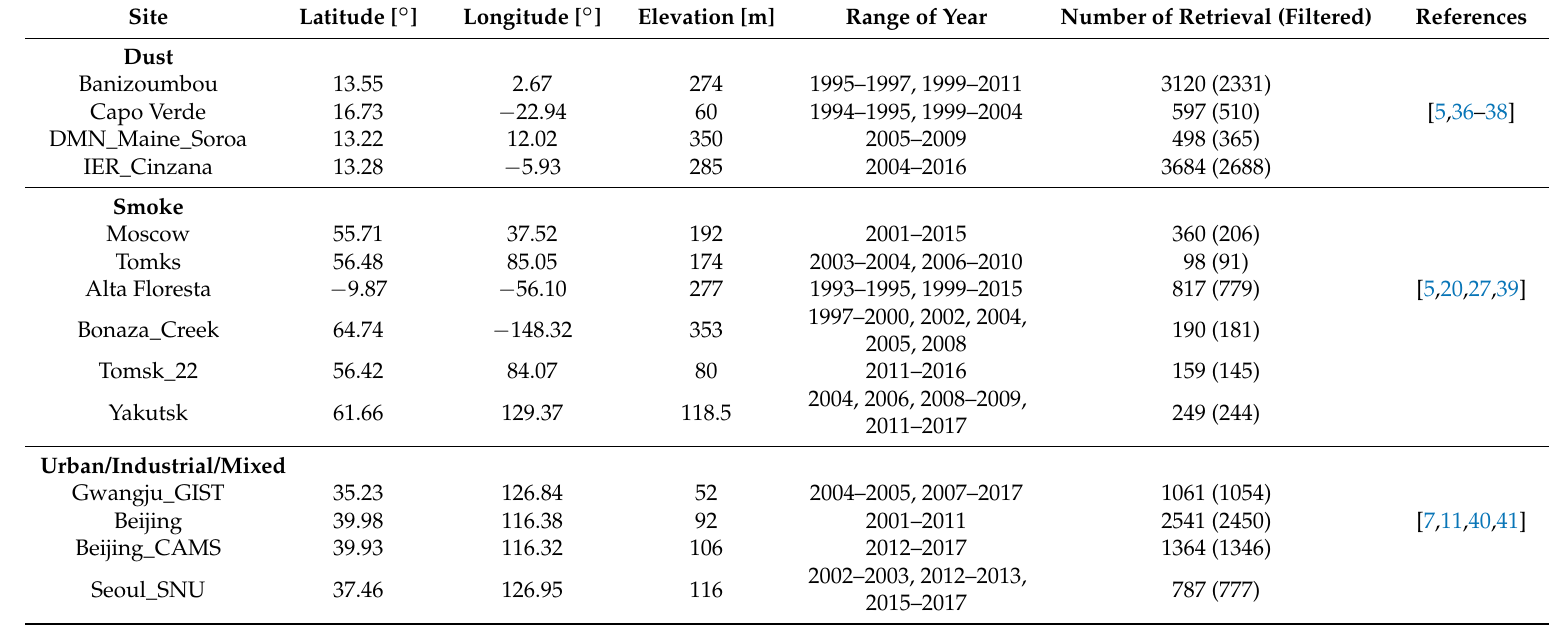
Table 1. Geographical/retrieval information for each aerosol type of the AERONET sites, along with corresponding literature citations. The number of cases of urban/industrial mixed aerosol is considered to equal number of cases that exclude the number of cases for dust